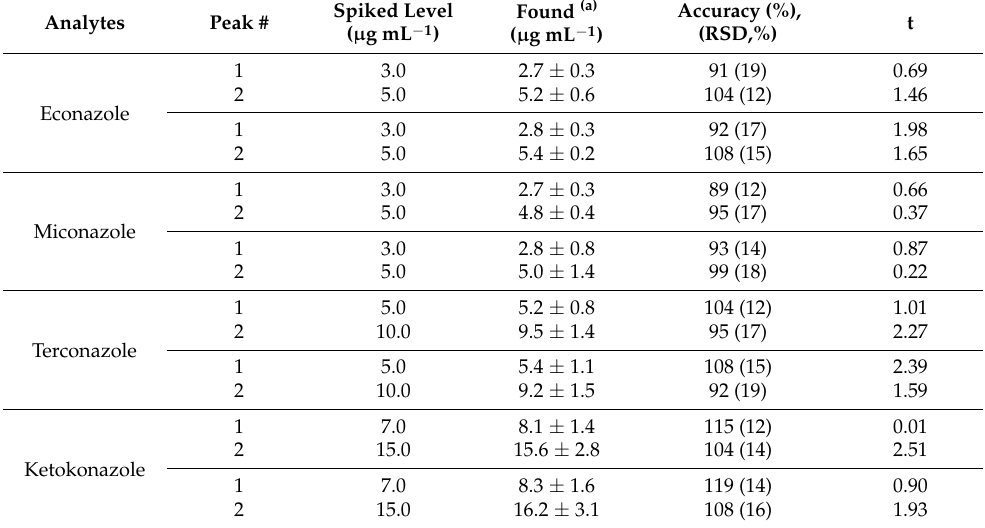
Table 4. Results of the precision and accuracy study of the DLLME–nano-LC–UV method on spiked milk samples. For experimental conditions, see Materials and Methods